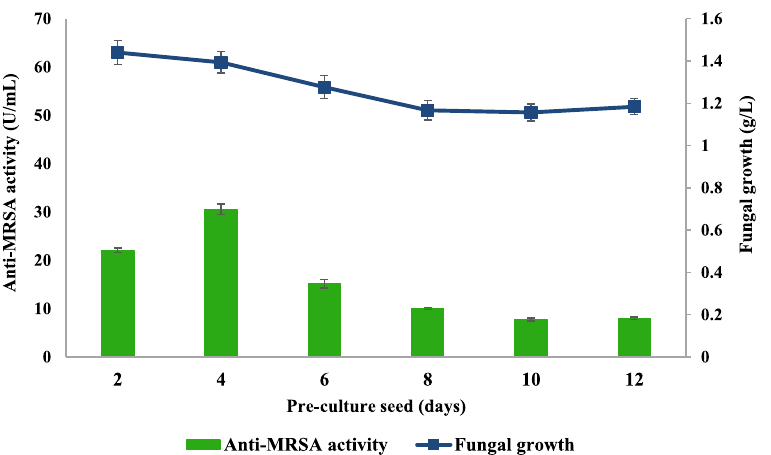
Fig. 2. Effects of pre-culture seed on production of anti-MRSA activity and fungal growth by L. pseudotheobromae IBRL OS-64. Different letters indicate significant differences between means (Duncan, p<0.05). Standard deviation values of triplicate analyses are shown by error bars.